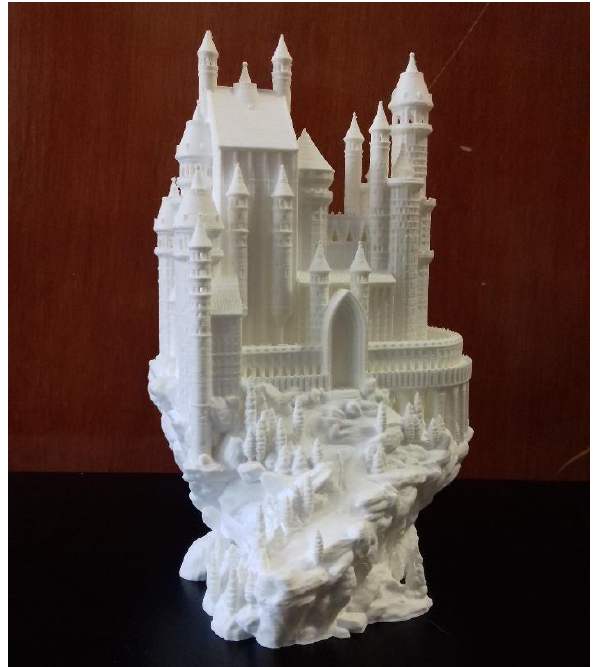
Figure 17. 3D print of medieval castle model